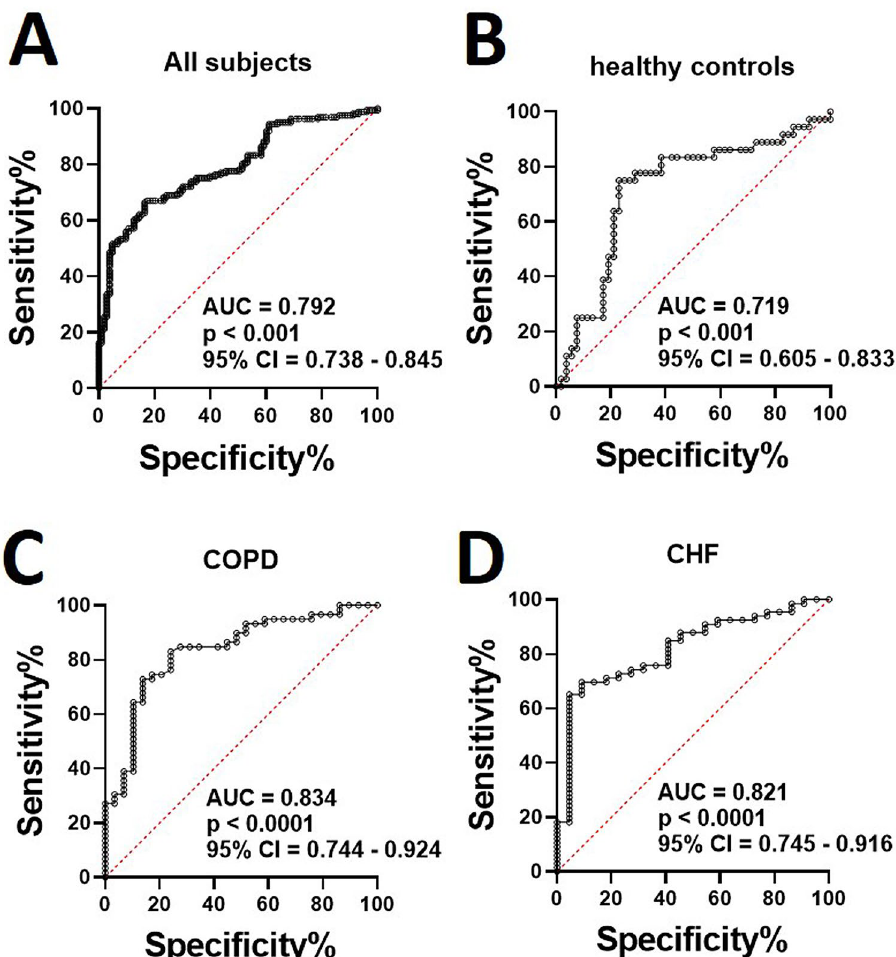
Figure 5. Significance of cumulative risk score for all the participants based on six biomarkers (P3NP, CAF22, osteonectin, irisin, FABP3 and MIF). Receiver operating characteristic (ROC) curves for all the